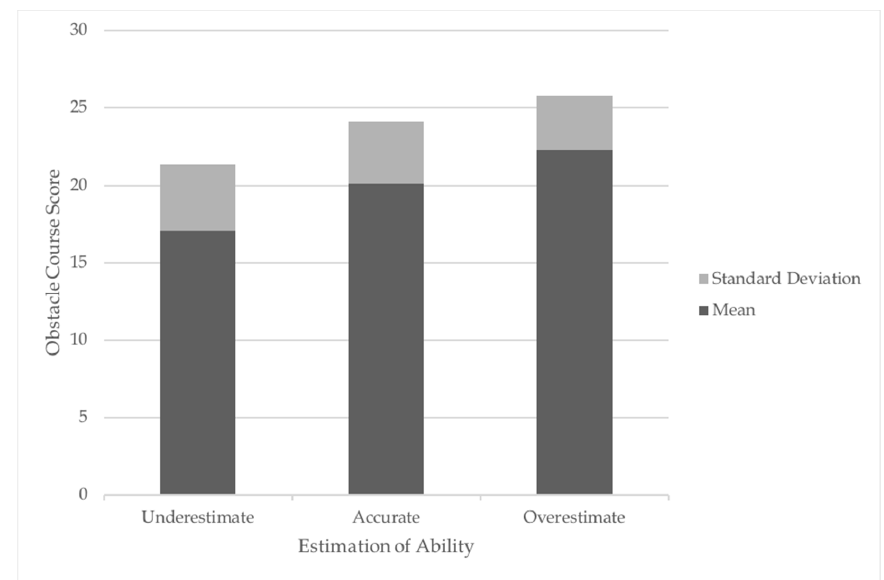
Figure 1. Average (SD) CAMSA scores of participants who under, accurate, or overestimated their motor competence.